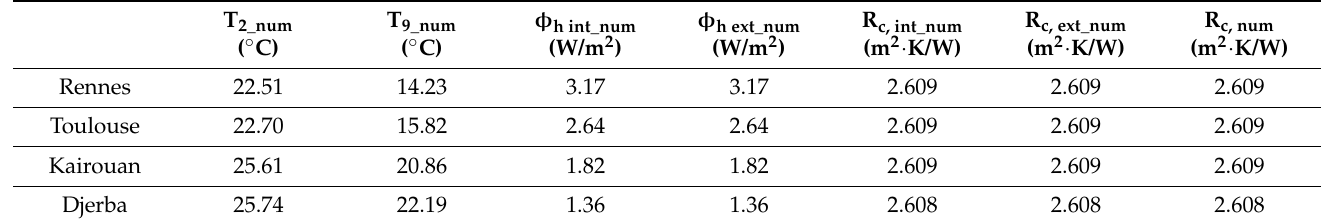
Table 6. Numerical heat fluxes and R c values after 180 days under constant temperature and vapor pressure gradients.